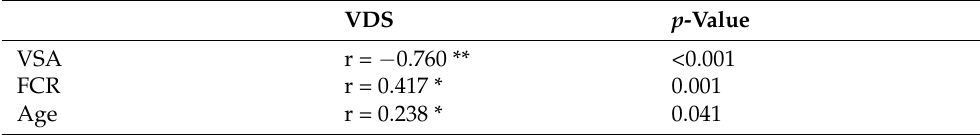
Table 2. Correlation analysis of the VDS with age, VSA, and